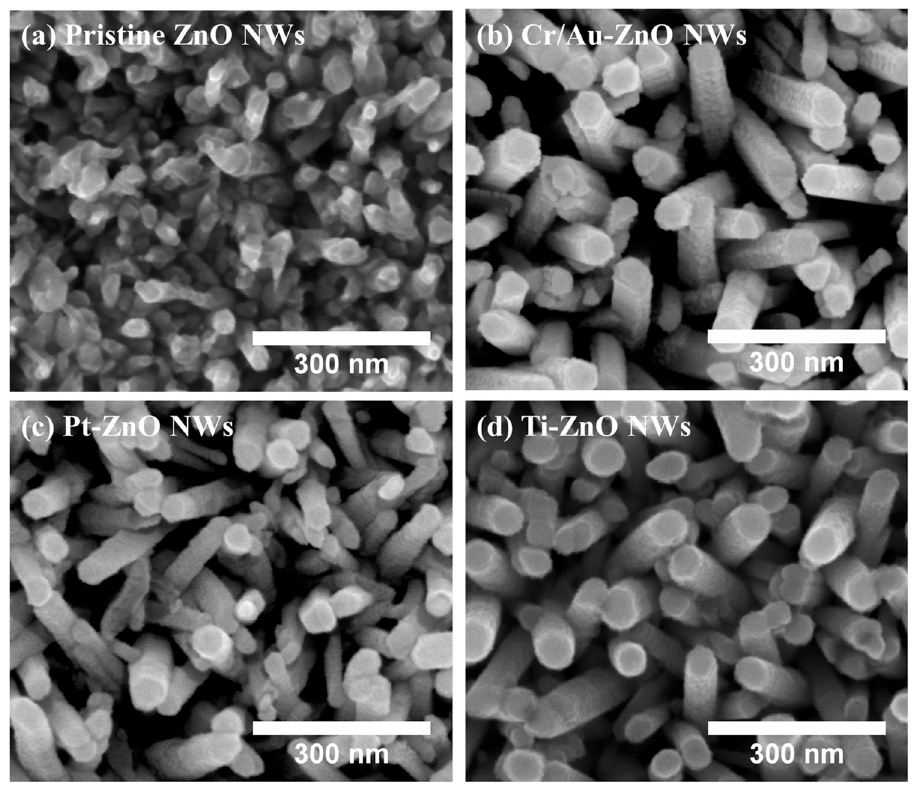
Fig 7. SEM images of (a) pristine ZnO NWs, (b) Cr/Au-ZnO NWs, (c) Pt-ZnO NWs, and (d) Ti-ZnO NWs. The SEM images were taken from the